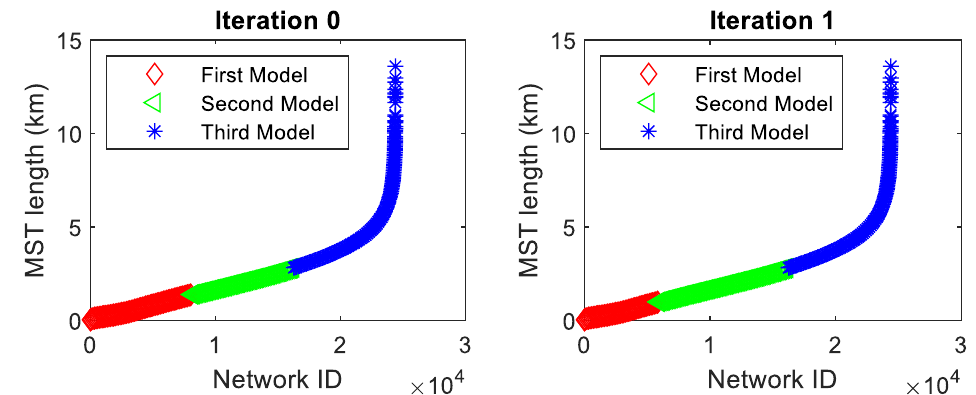
Figure 6. Network assignment. This procedure firstly assigns the same number of networks to each model and then reassigns networks from the first to the second model. The networks are sorted according to the length of the MST. Table 3. Mini-grids assigned to each